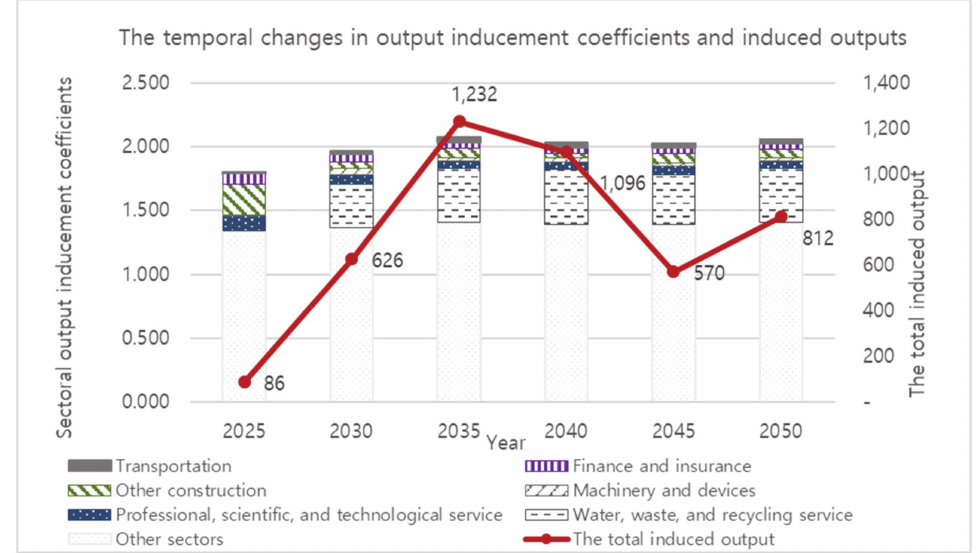
Figure 4. The total and sectoral output inducement coe ffi cients of nuclear decommissioning.